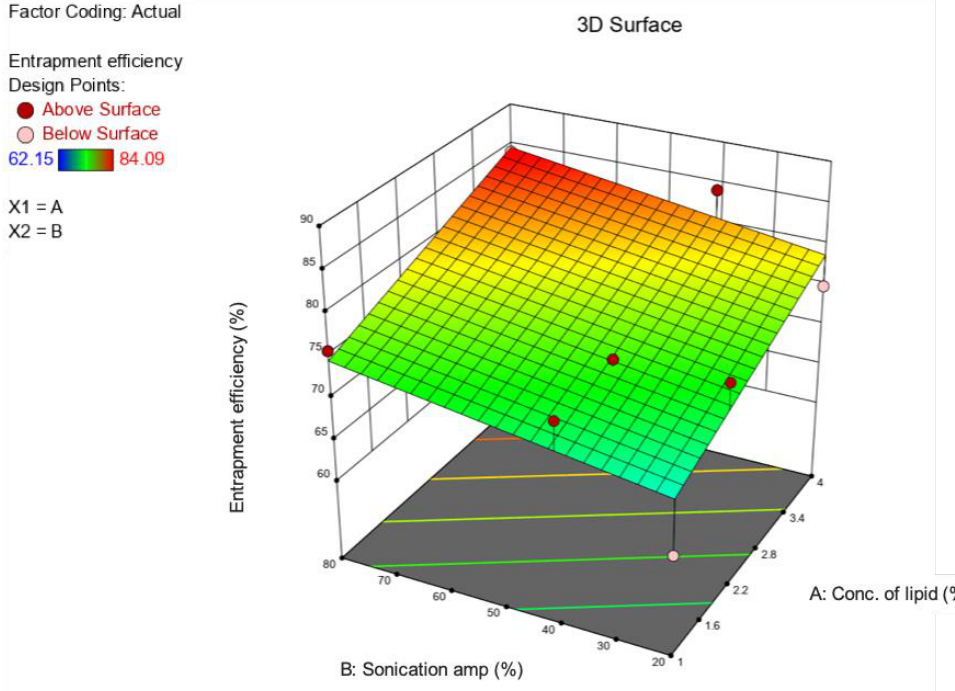
Figure 5. The 3D response surface plot showing the effects of the lipid concentration ( A ) and